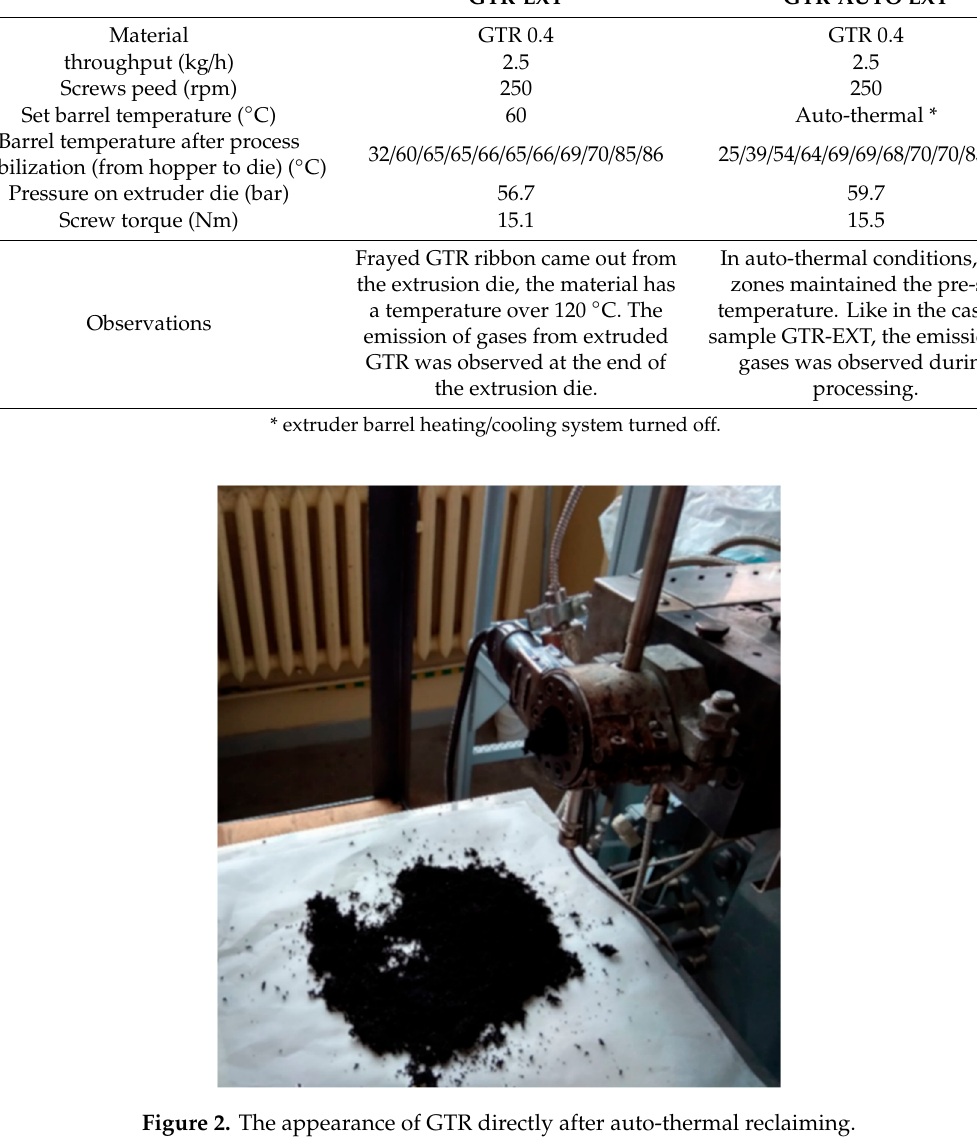
Figure 2. The appearance of GTR directly after auto-thermal reclaiming .